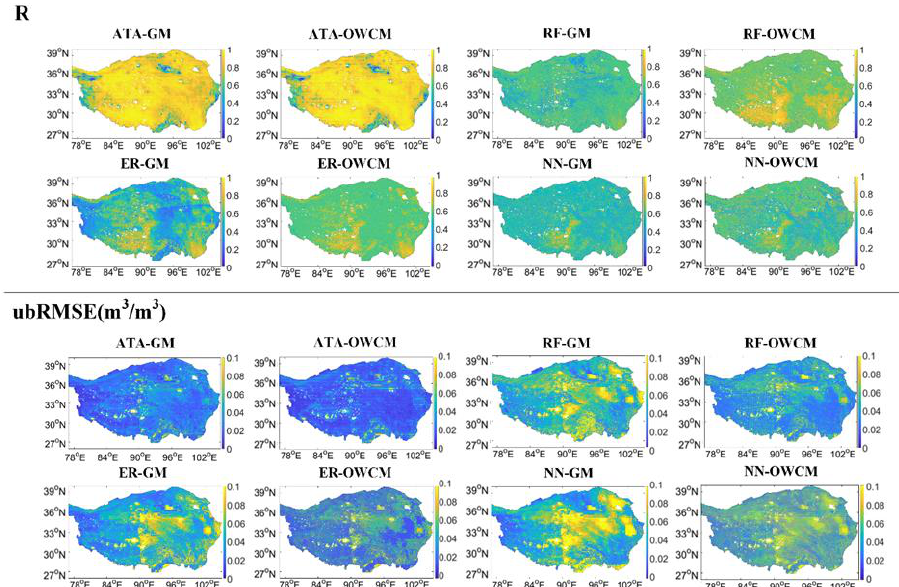
Figure 6. Spatial distributions of the statistical metrics R and ubRMSE between the aggregated OWCM-/GM-derived SM and the original RFSM. As a summary of the information presented in Figure 6, Figure 7 shows the spatial frequency distributions of the statistical metrics R, ubRMSE, and bias between the ag- gregated OWCM-/GM-derived SM and the original RFSM over the QTP. In general, the distribution of OWCM-derived SM metrics is notably superior to that of the corre- sponding GM-derived SM products, and the ATA-OWCM SM products perform the best overall.